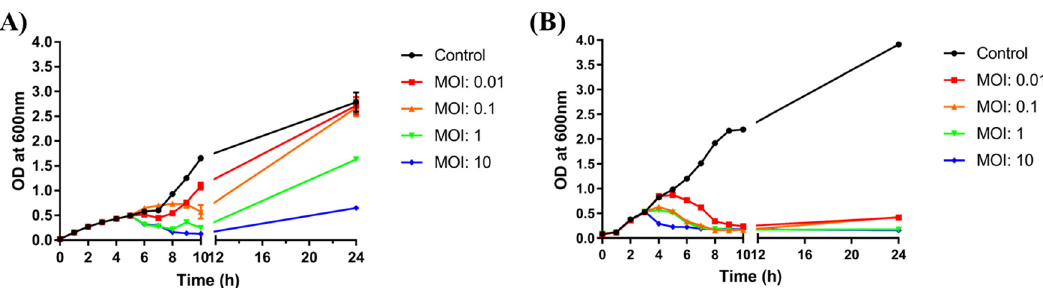
Figure 6. Bacterial challenge assay with ECP26 and BECP10. ( A ) Antibacterial activity of phage ECP26 according to various MOIs at 37 °C. ( B ) Antibacterial activity of phage BECP10 according to various MOIs at 37 °C. Phages were inoculated at 3 h after bacterial growth and the OD 600 was periodically monitored to determine phage activity for 24 h. SM buffer was used as the negative control.